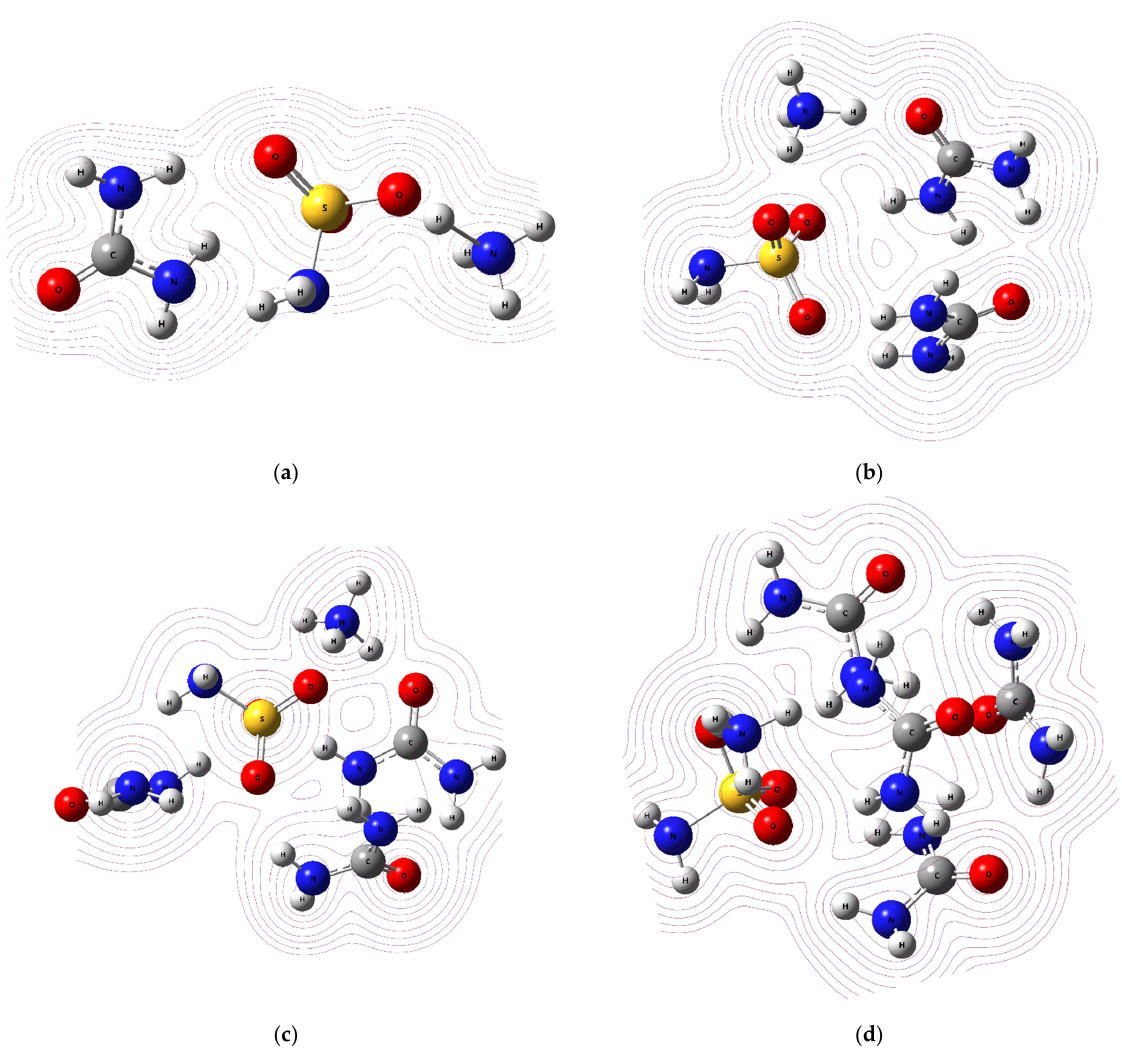
Figure 7. MEP surfaces for ( a ) ASA–urea 1, ( b ) ASA–urea 2, ( c ) ASA–urea 3, and ( d ) ASA–urea 4.